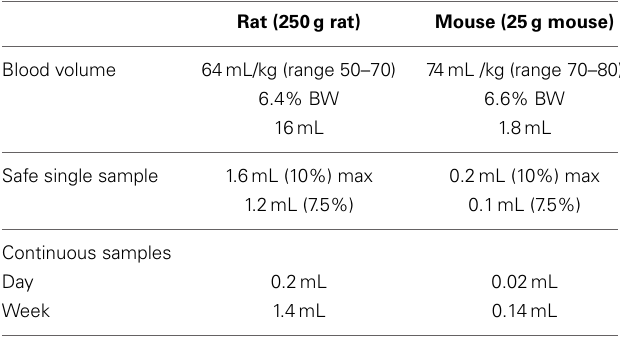
Table adapted from Diehl et al. [81] and from the German Society for Laboratory Animal Science (GV SOLAS). BW, body